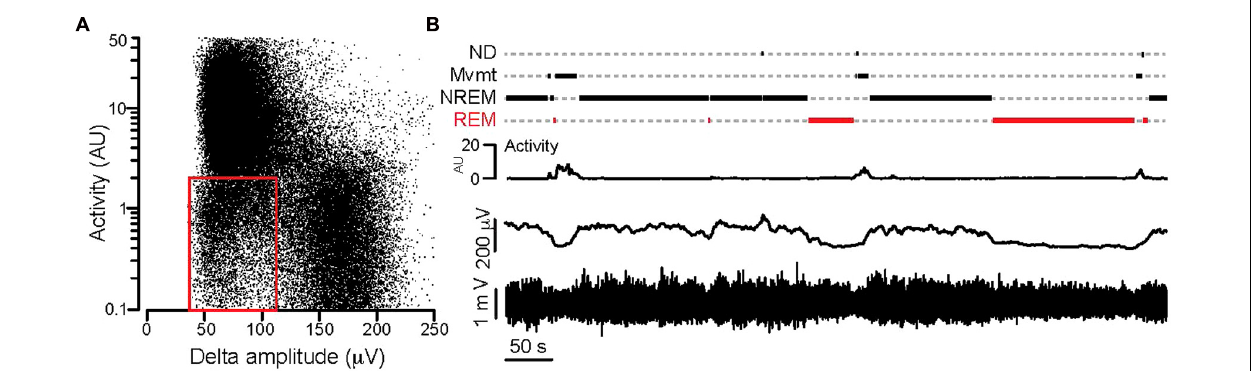
FIGURE 1 | Separation of behavioral states based on synchronous video and local field potential recordings. (A) Activity values plotted against the Hilbert magnitudes in the δ frequency range (1–4 Hz) for each 1 s long epoch (total: 86,400 epochs) during a full day of synchronous video-local field potential recording. Note the appearance of three clusters in the point cloud. The red rectangle delineates the point cluster corresponding to the putative REM sleep. (B) Separation of behavioral states based on combined activity